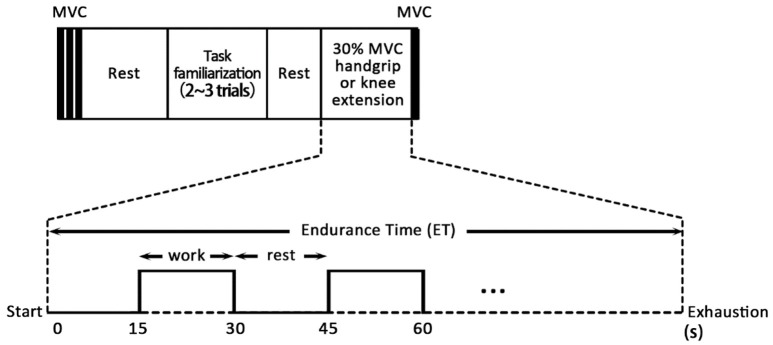
Experiment Protocol.